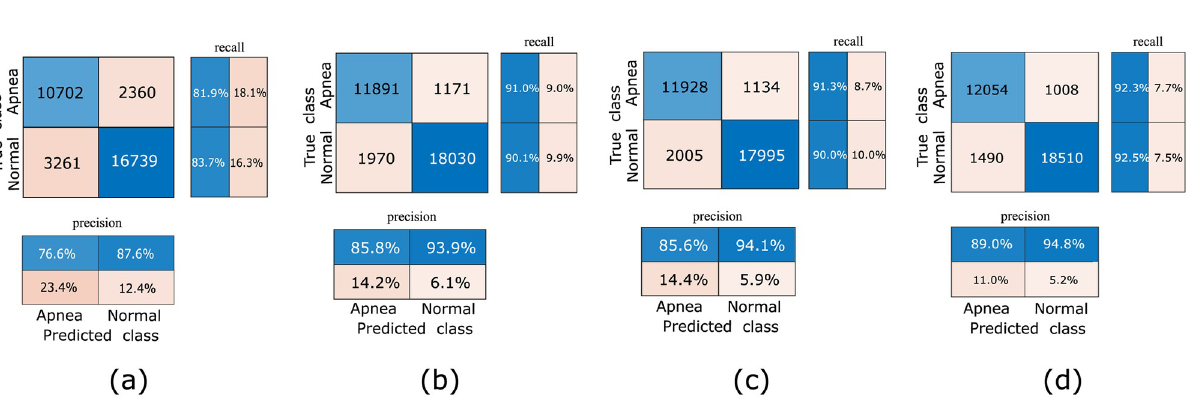
PLOS ONE | https://doi.org/10.1371/journal.pone.0250618 April 26,